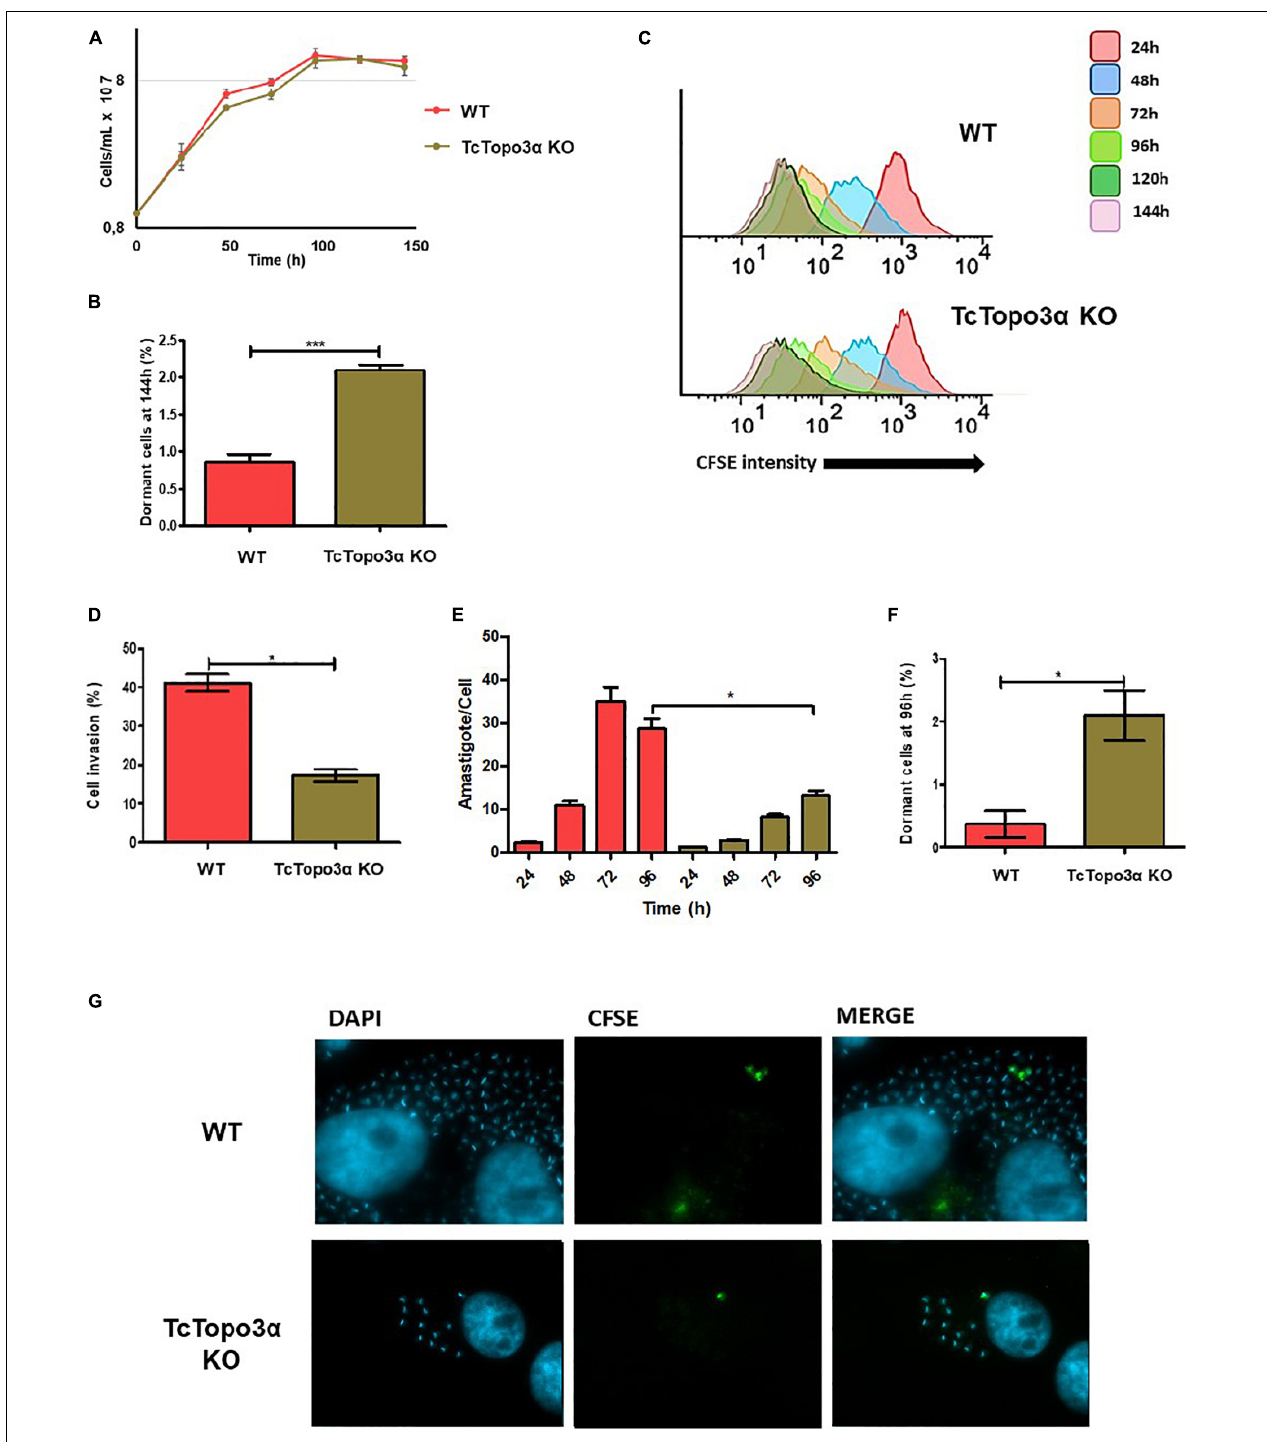
FIGURE 2 | Proliferation behavior of TcTopo3 α KO T. cruzi epimastigotes and amastigotes, and trypomastigote invasion profile. (A) Epimastigote cellular growth curves from WT and TcTopo3 α KO. At 0 h, 1 × 10 7 cells were treated with CFSE, and samples were counted every 24 h for 144 h. (B) Average of percentage of dormant cells in WT and TcTopo3 α KO strains at 144 h was detected in flow cytometry histograms. (C) Flow cytometry histograms of epimastigote cultures from each strain from 24 to 144 h. CFSE intensity was assessed every 24 h until 144 h, and arrested cells were considered as those ones which exhibited similar CFSE intensity at 144 h when compared with the level of half median at 24 h. (D) Invasion rate of WT and TcTopo3 α KO strains in LLC-MK2 cells. The graph shows the percentage of infected LLC-MK2 cells in a total of 250 cells that were analyzed (parasites labeled with anti- T. cruzi antibody were disregarded). (E) T. cruzi